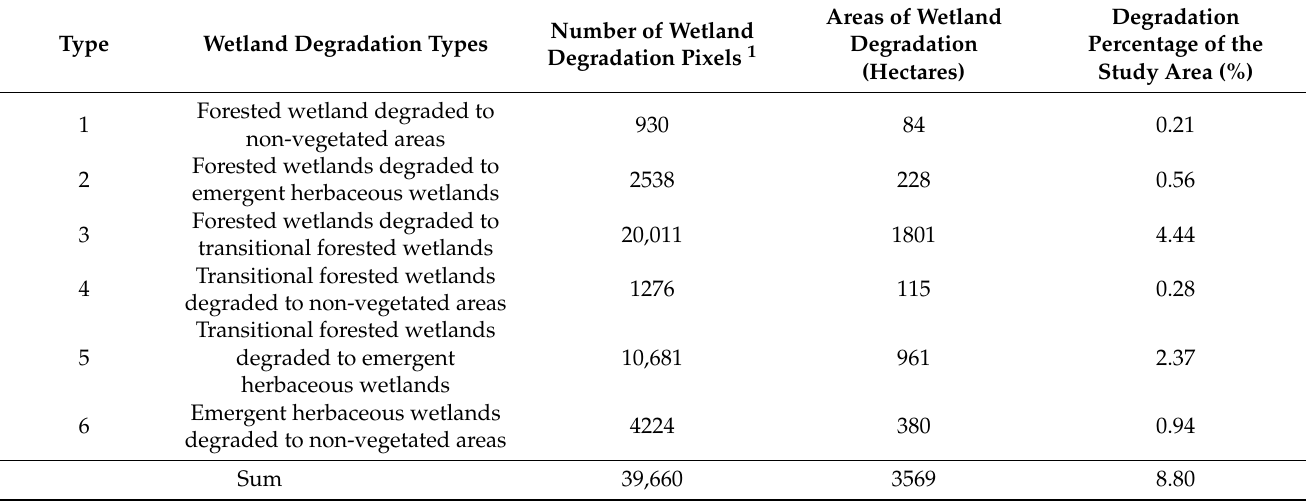
Table 2. Identified Wetland degradation over the ARNWR from